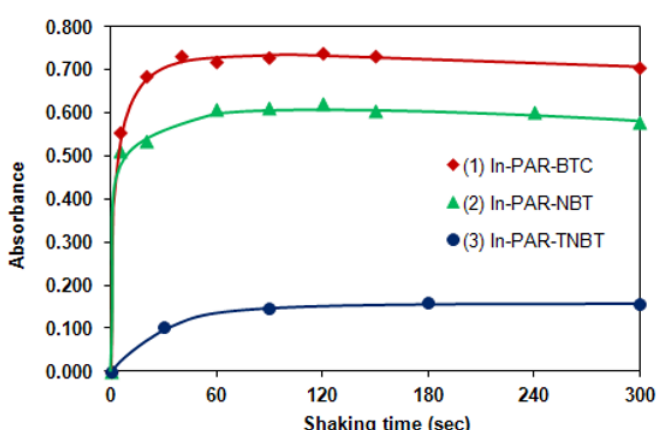
=1×10 −5 mol L −1 , C In(III) L ] 4– + 2H O 3 2 2